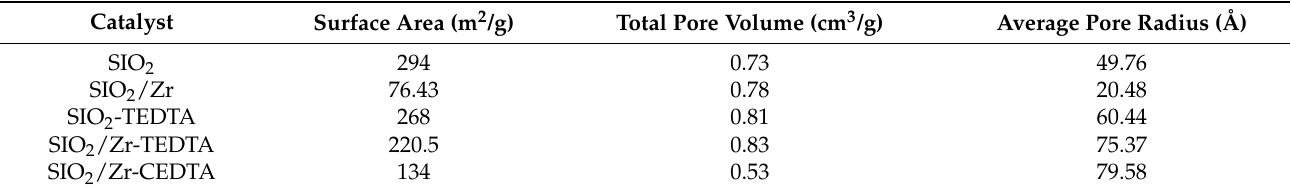
Table 2. Textural features of catalysts.